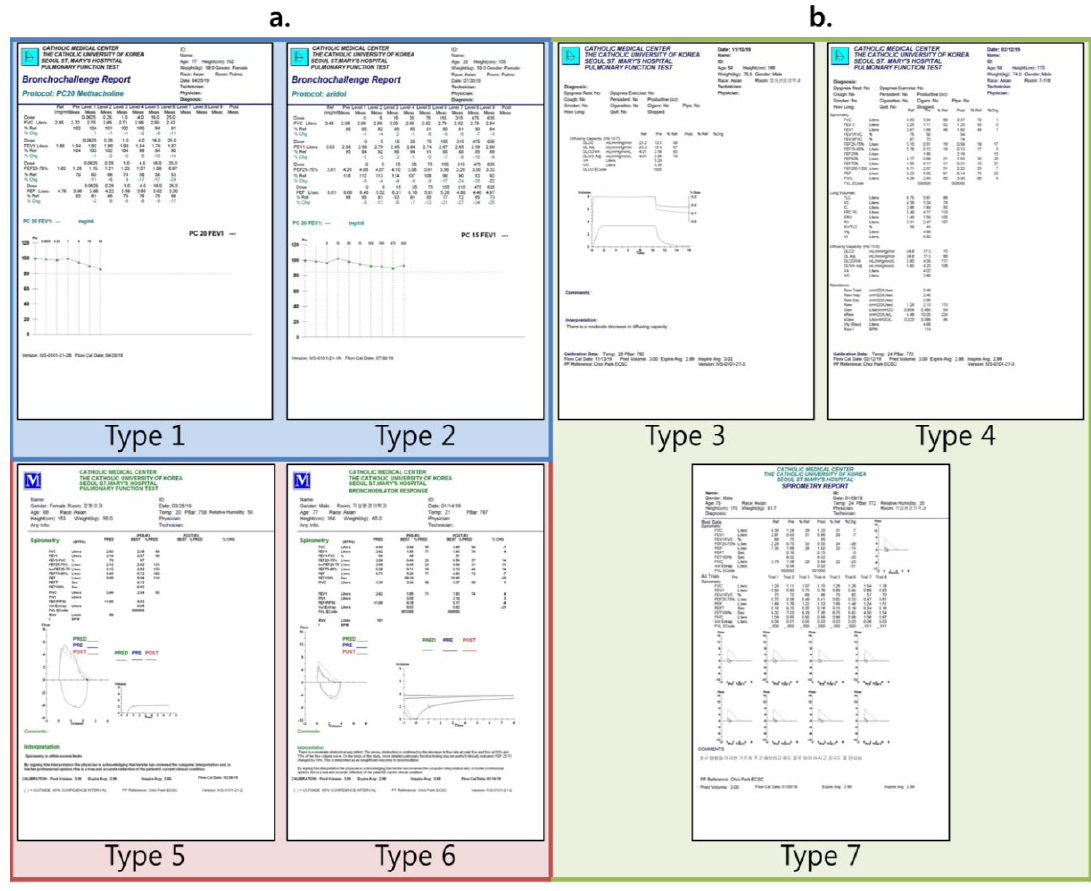
Figure 7. Samples of de-identified PFT sheets classified by CIMI system; ( a ) similar form of Type 1 and Type 2; ( b ) similar form of Type 3, Type 4 and Type 7; ( c ) similar form of Type 5 and Type